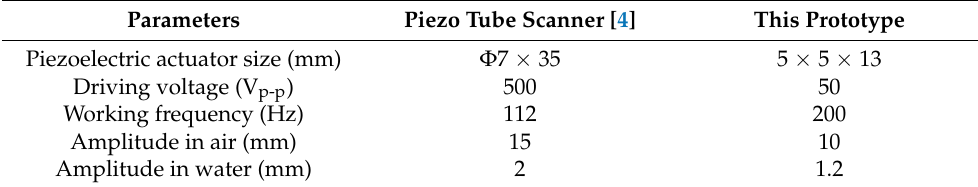
Table 3. Performance comparison with the piezo tube